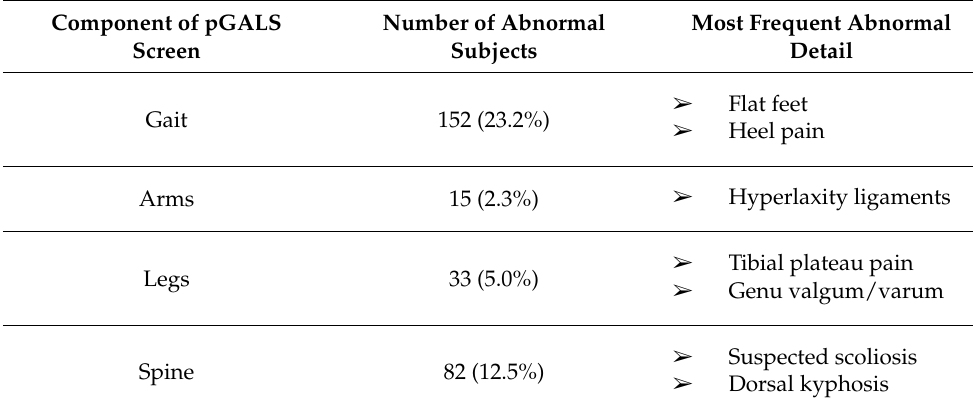
Table 2. Abnormal findings of pGALS screening.